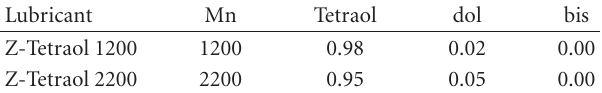
Figure 1: Chemical structure of Z-Tetraol.